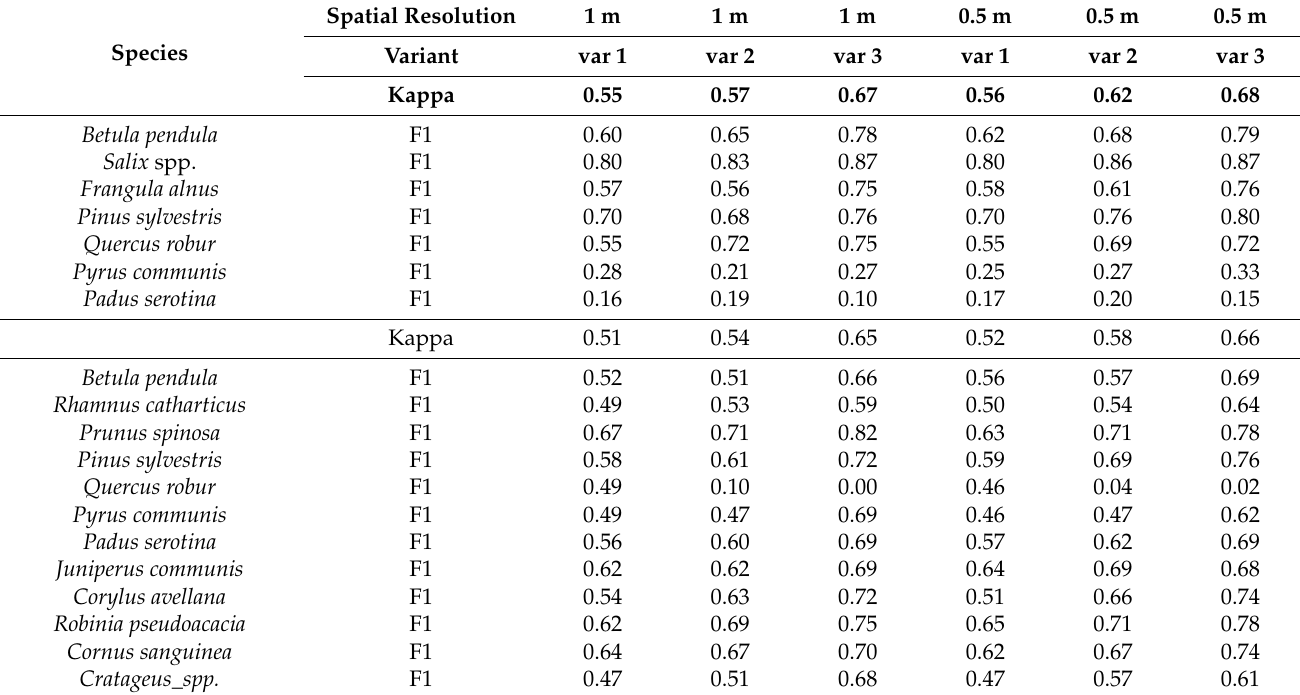
Table A3. Accuracy assessment report of the influence the spatial resolution of the hyperspectral data has on the results of the species classification (var 1—reference polygons were buffers with a crown diameter of a tree or shrub, var 2—reference polygons were buffers limited using the height criterion, the presence of vegetation and shadows, var 3—same as var 2, but characterized by more stringent threshold